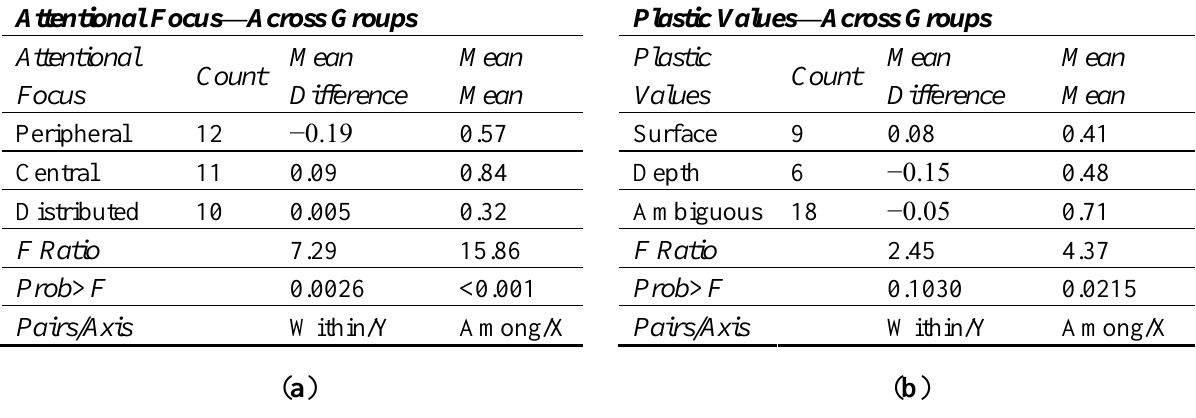
Table 2. Matched Pairs Comparison on Copy Exercise: Reproductions in Original versus Altered Drawings. ( a ) Grouped by Attentional Focus; ( b ) Grouped by Plastic Values.